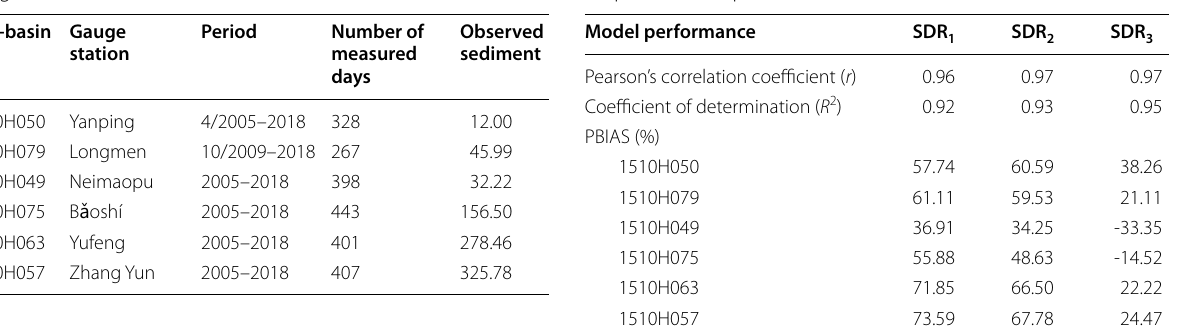
Table 7 Model performance evaluation corresponding to